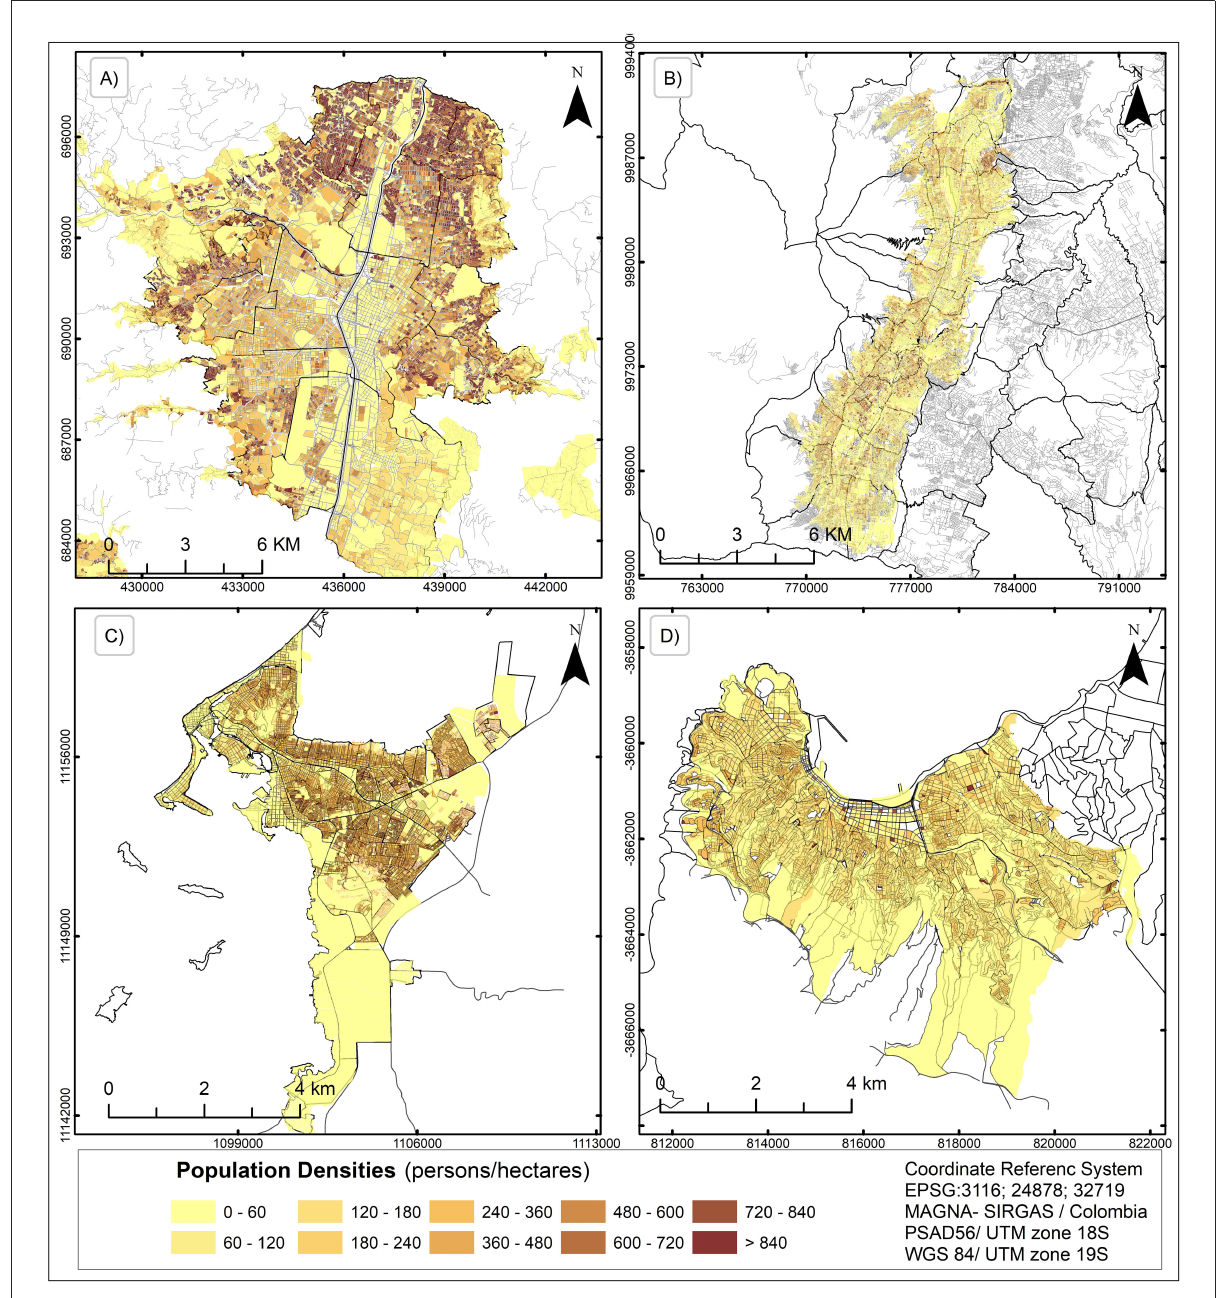
FIGURE5 Population density: Medellín (A) , Quito (B) , Cartagena (C) , and Valparaíso (D). Source: Prepared by the authors based on (INEC, 2010; INE, 2017; DANE, 2018).